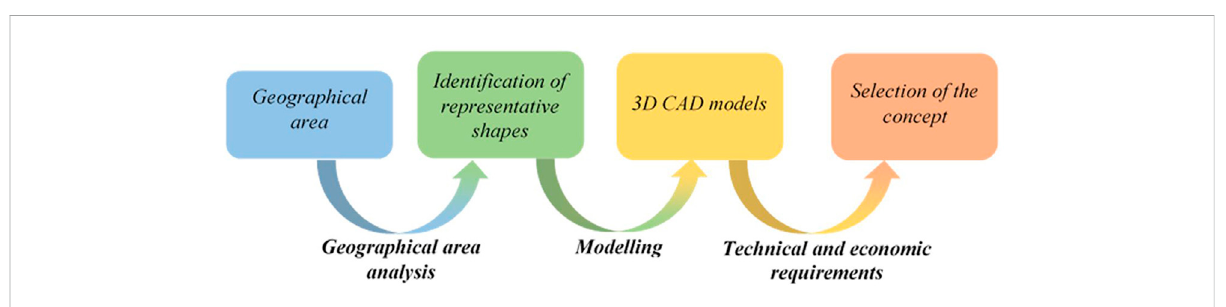
FIGURE 4 Main steps of the development of conceptual